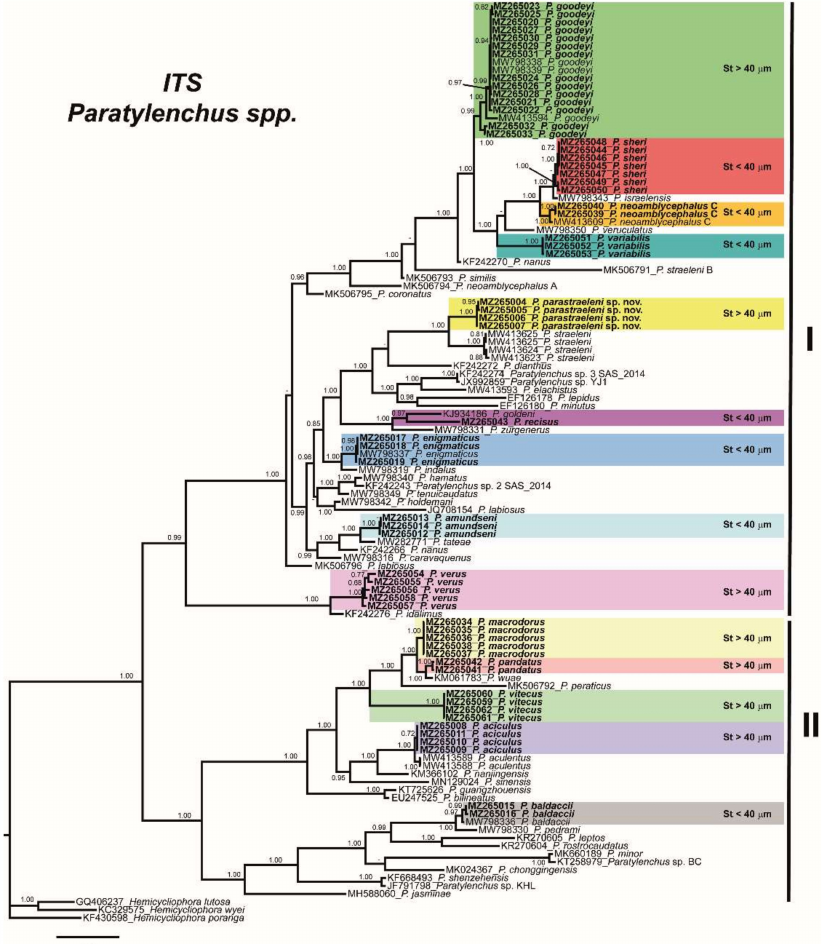
Figure 17. Phylogenetic relationships within the genus Paratylenchus . Bayesian 50% majority rule consensus tree as inferred from ITS rRNA sequence alignment under the general time-reversible model of sequence evolution with correction for invariable sites and a gamma-shaped distribution (GTR + I + G). Posterior probabilities of more than 0.70 are given for appropriate clades. Newly obtained sequences in this study are shown in bold. The scale bar indicates expected changes per